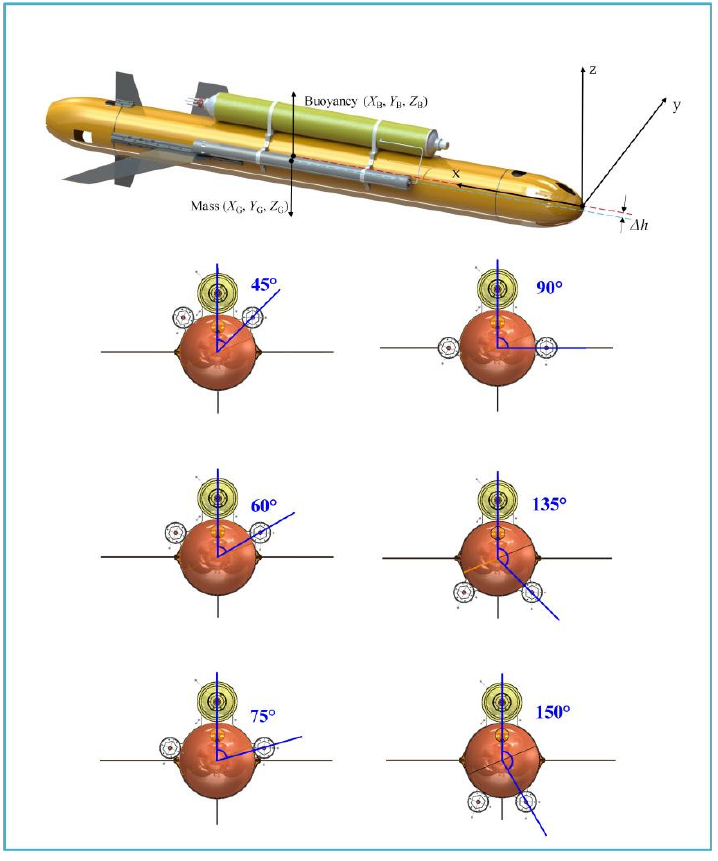
Figure 3. Six installation angles of the thermal energy power generation module. Table 1. Between center of mass and buoyancy of the integrated vehicle at different installation angles.